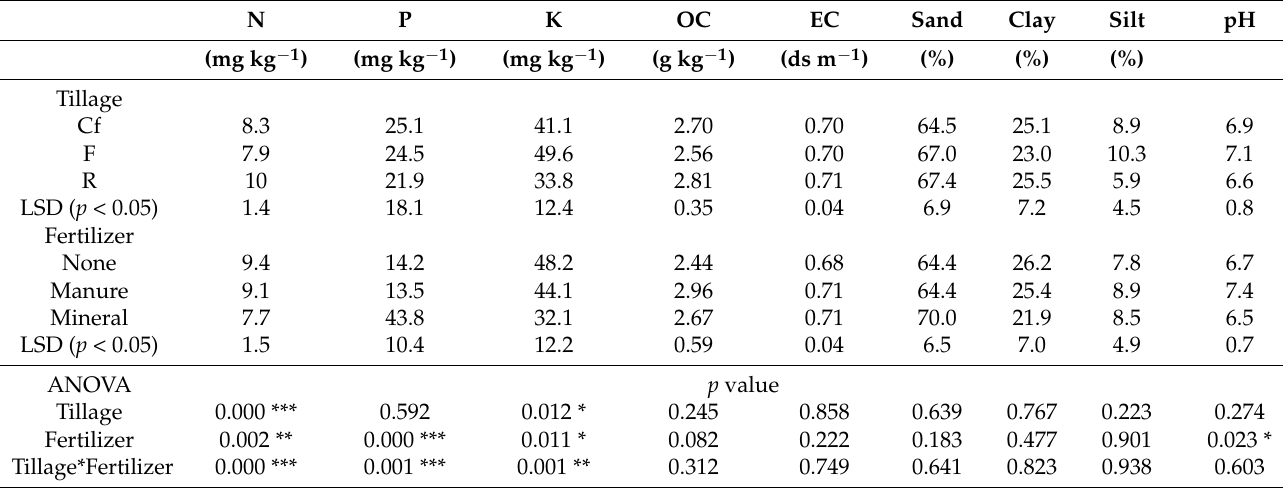
Table 4. Residual effects of tillage and fertilizer treatments for soil characteristics (0–10 cm) in April 2018 after completion of the second year of the